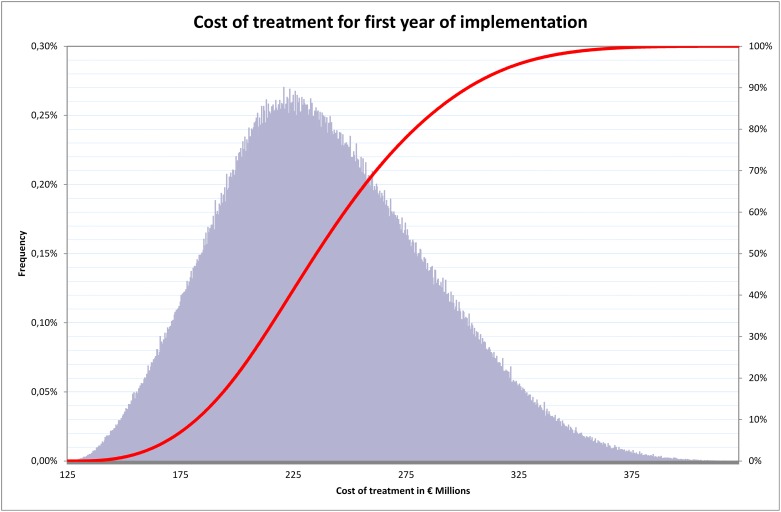
Probabilistic sensitivity analysis frequency and cumulative frequency of cost of cessation treatment.